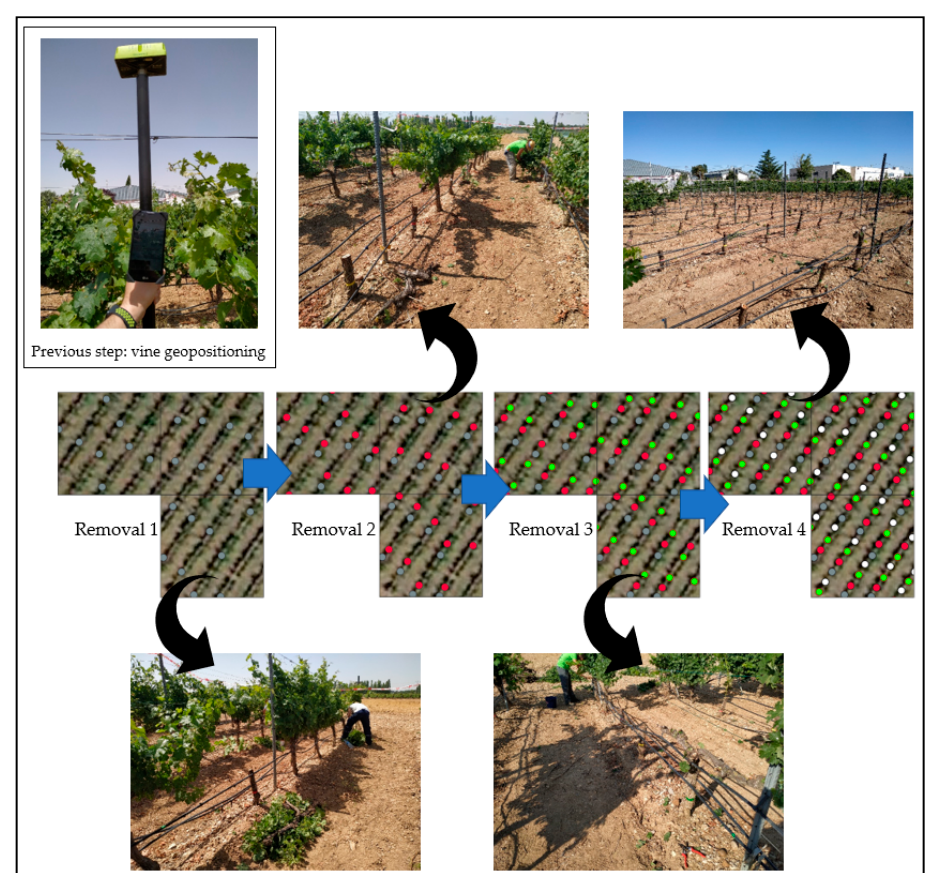
Figure 2. Schematic representation of the four-step vine removal implemented in the field experiment.